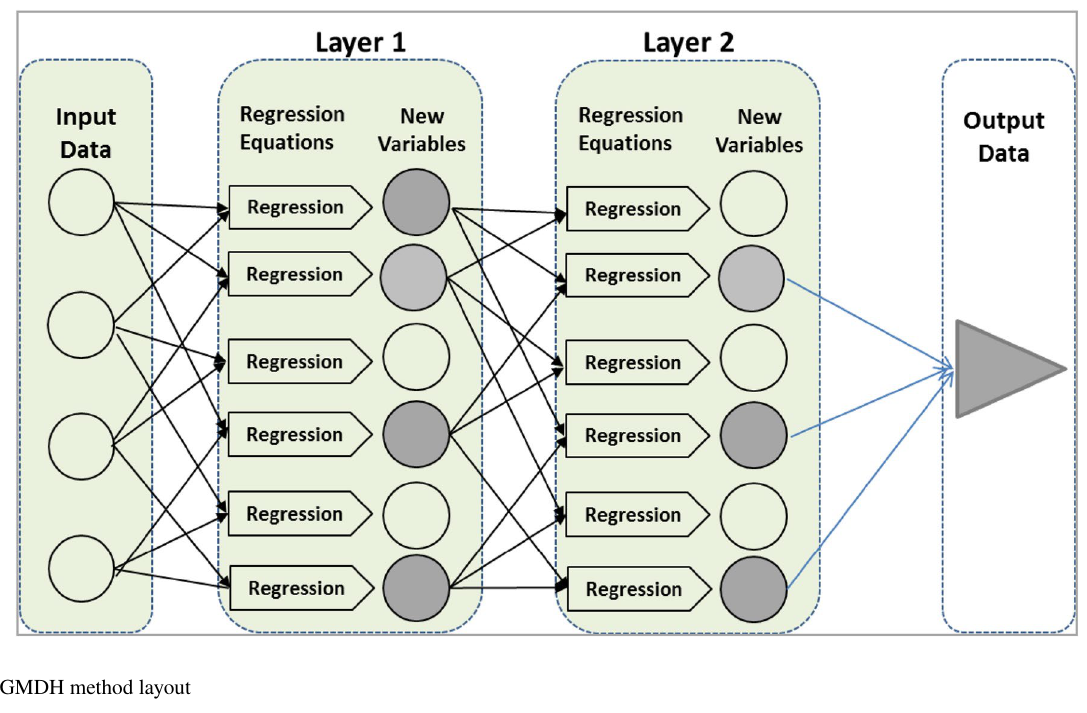
Fig. 12 GMDH method layout